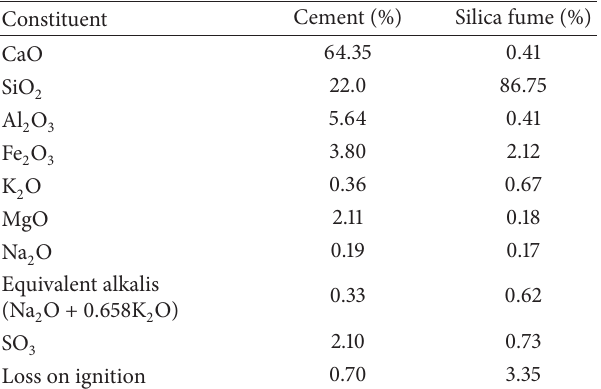
Table 1: Chemical composition of cement and silica fume.